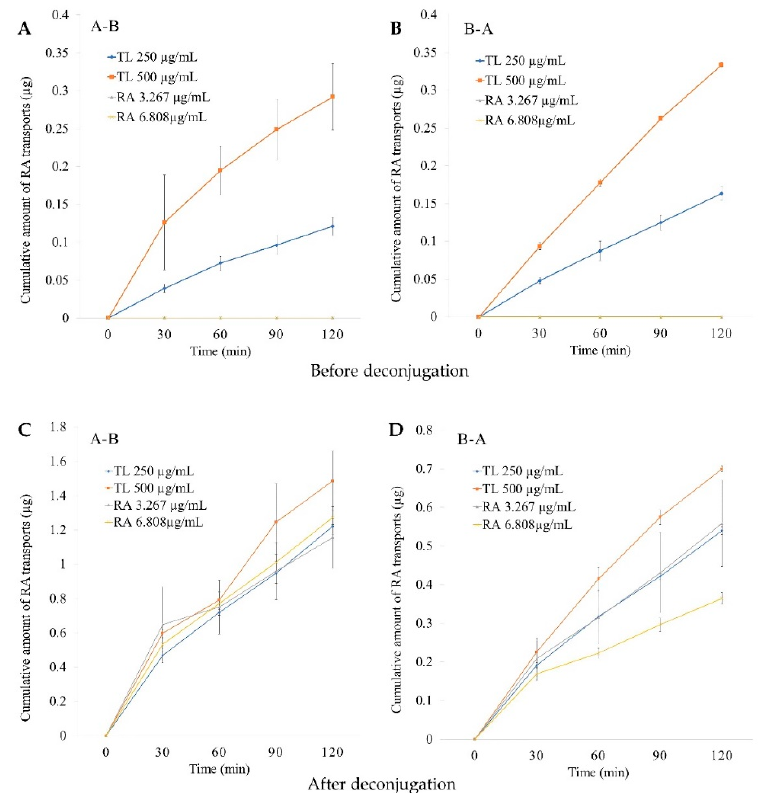
Figure 5. Cumulative amount of RA transports in 250 and 500 μ g / mL TL extracts across Caco - 2 cell monolayers over time in both directions: A–B ( A ) and B–A ( B ) directions before deconjugation, and A–B ( C ) and B–A ( D ) directions after deconjugation. The data represent the mean ± SD from three replicates .